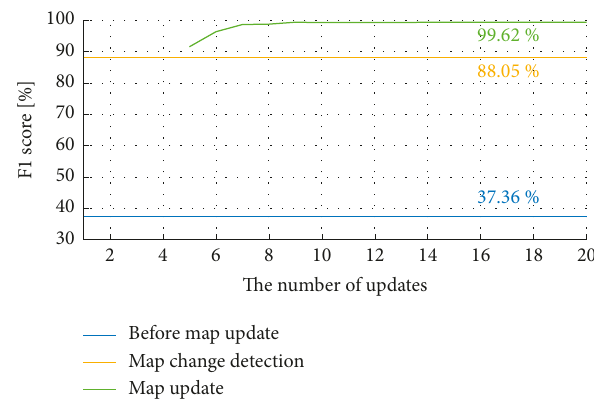
Figure 17: F1-scores by the number of crowd-sourcing vehicles in